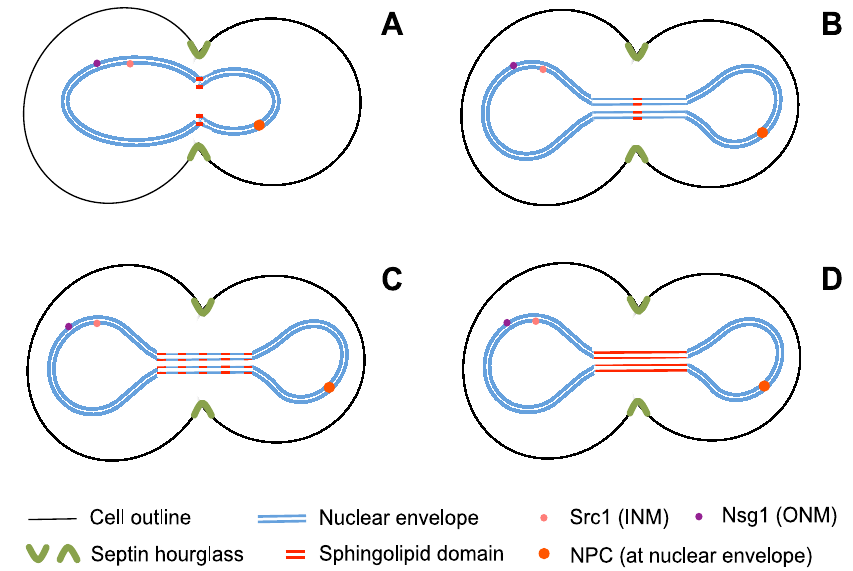
Figure 3. Possible diffusion barrier scenarios, constituted by different specialised lipid domain configurations. For early anaphase: ( A ) a ring-shaped domain at the neck of mitotic nuclei in early anaphase. For late anaphase: ( B ) a single ring-shaped domain centred at the bridge between nuclear lobes, ( C ) a set of parallel rings uniformly spaced along the bridge, and ( D ) a homogeneously distributed domain spanning the entire bridge length.